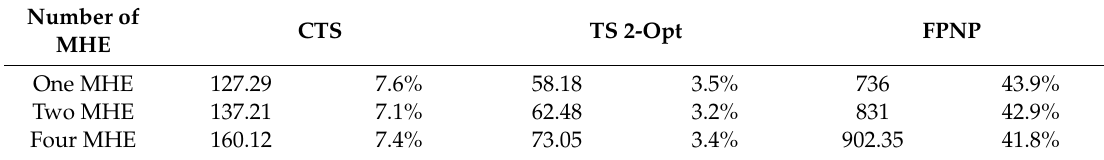
Table 5. Time savings (seconds) and percentage savings (%) of discrete PSO by FMHE.